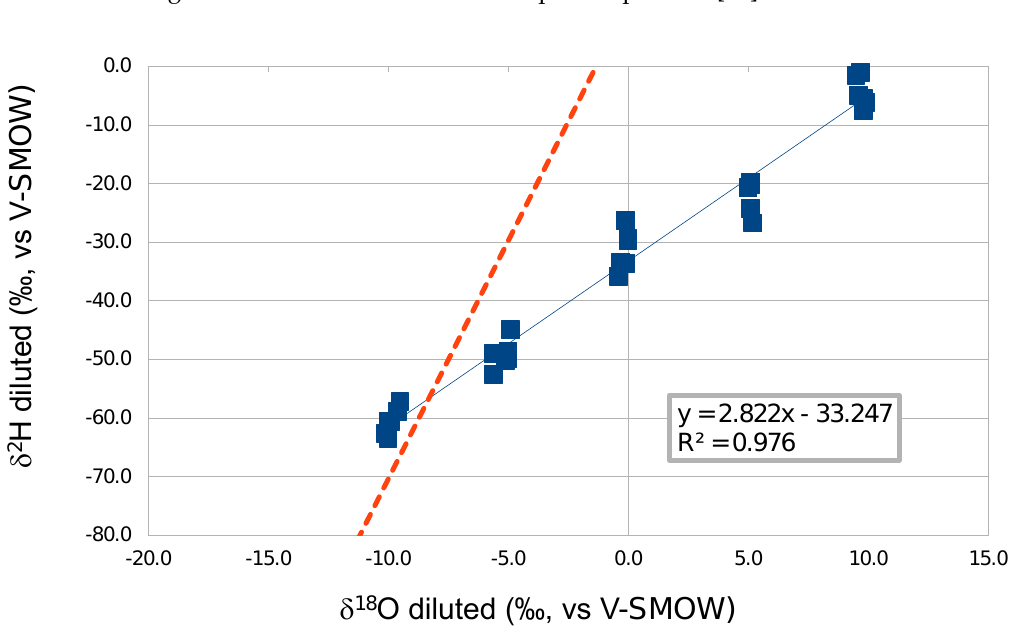
Figure 4. Correlation between δ 18 O and δ 2 H of diluted sugar solutions (data for all three types of sugars). The Global Line of Meteoric Waters is the dotted one.